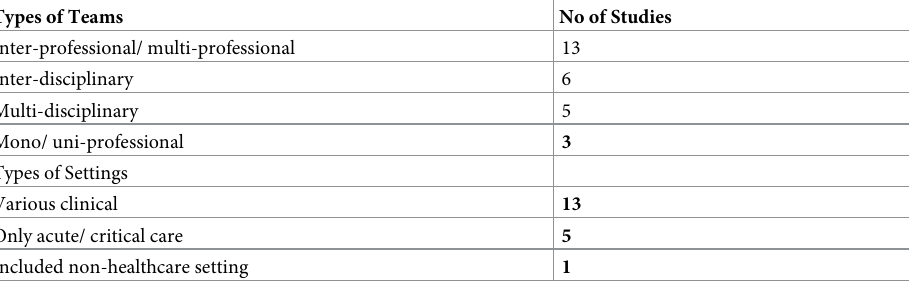
Table 2. Types of teams and setting observed in the reviewed